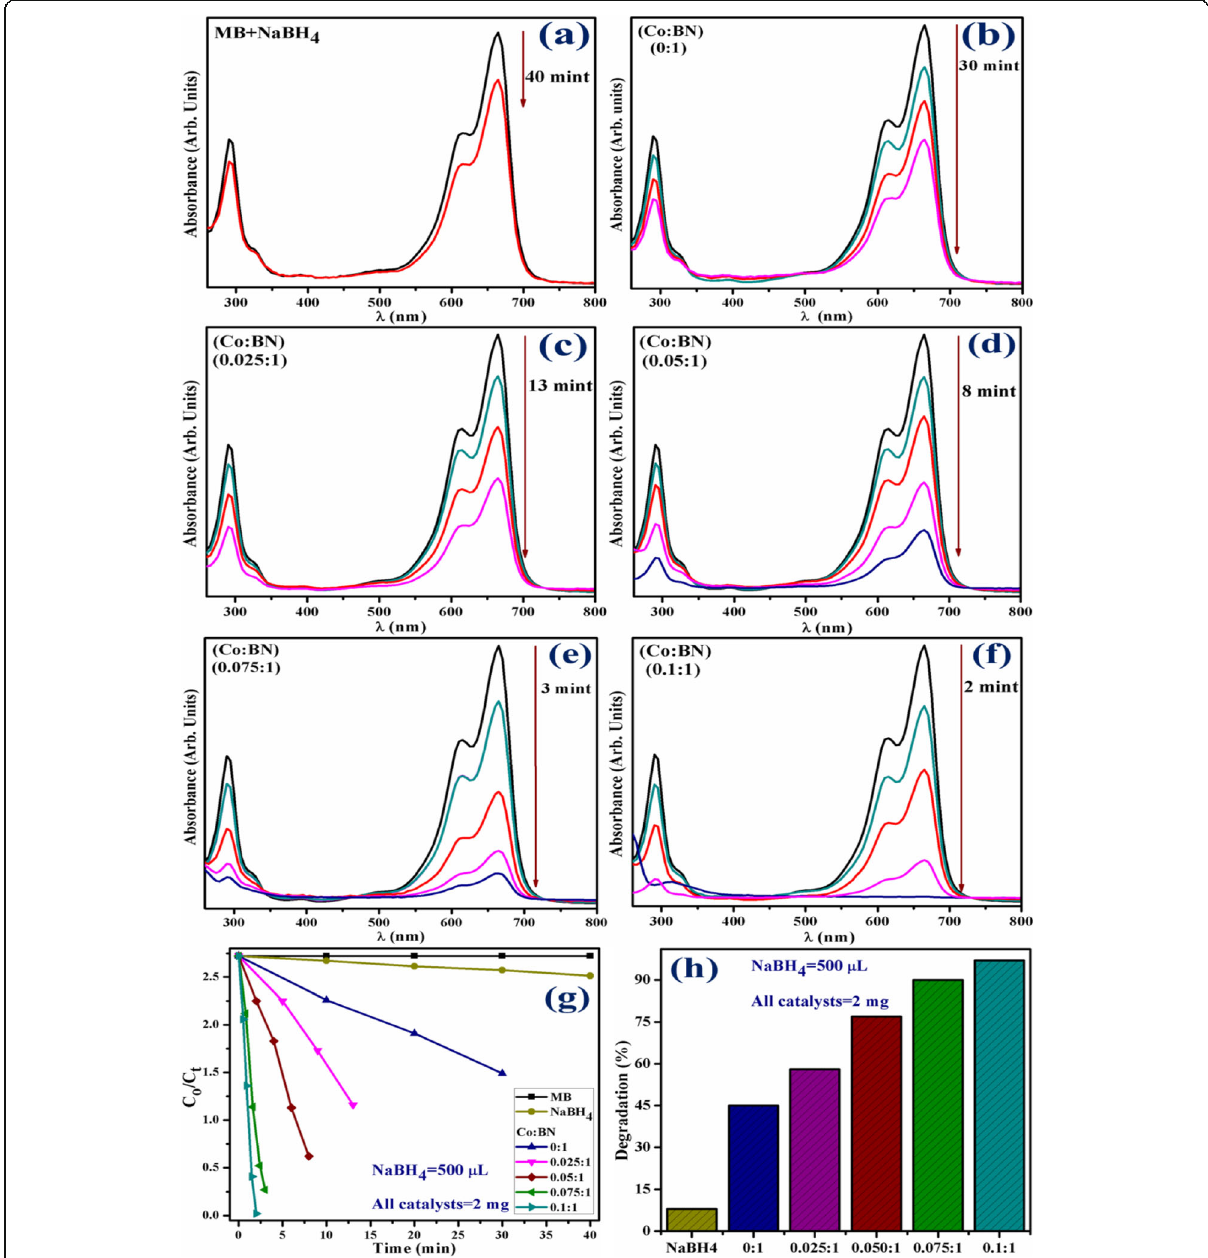
Fig. 10 a Time-dependent UV-vis spectra of NaBH 4 . b pristine BN-NS. c – f Various concentrations (2.5, 5, 7.5, and 10 wt%) of Co-doped BN-NS. g Plots of C t / C o versus time. h Comparison of degradation percentage over various concentrations of